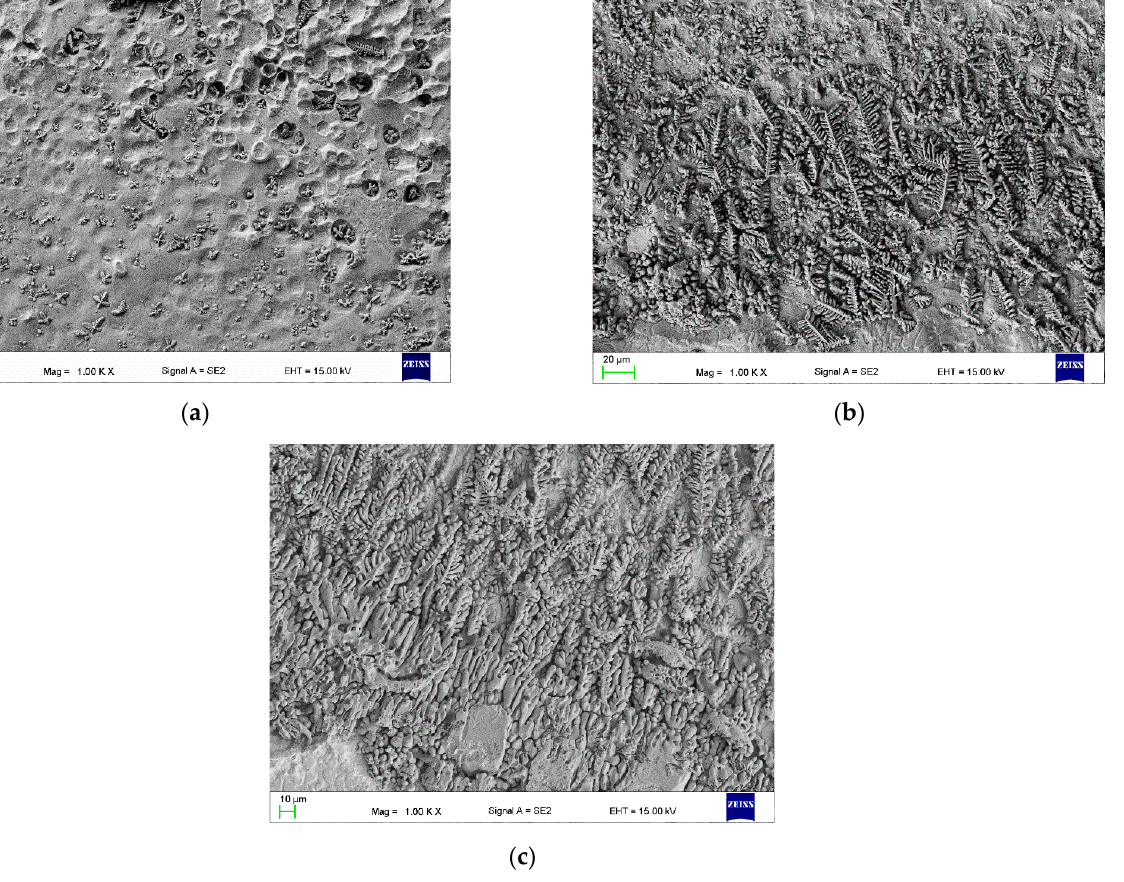
Figure 4. Cross section of the top layer of the Cu-ETP guide after fusion of CrAl powder: powder feed rate ( a ) 0.2 mm 3 /min; ( b ) 0.4 mm 3 /min; ( c ) 0.8 mm 3 /min; SEM.